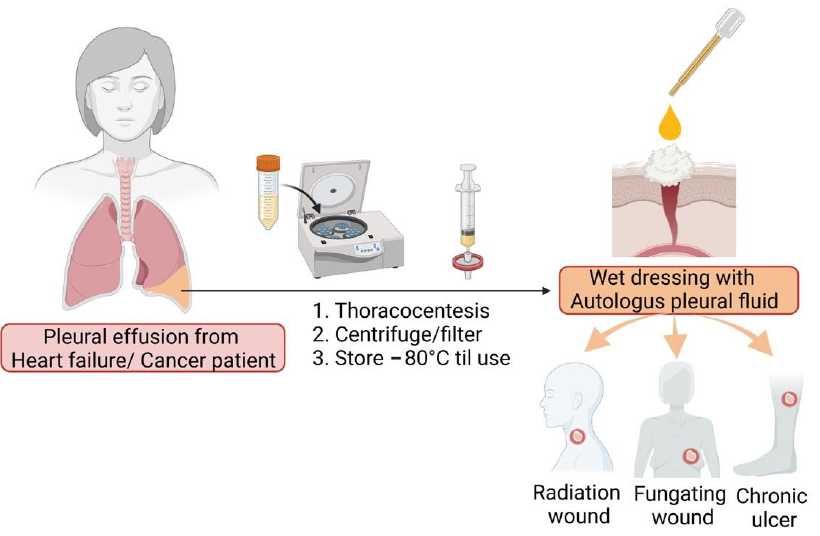
Figure 11. Proposal for the use of autologous pleural fluid in treating cancer patients with non- healing wounds.